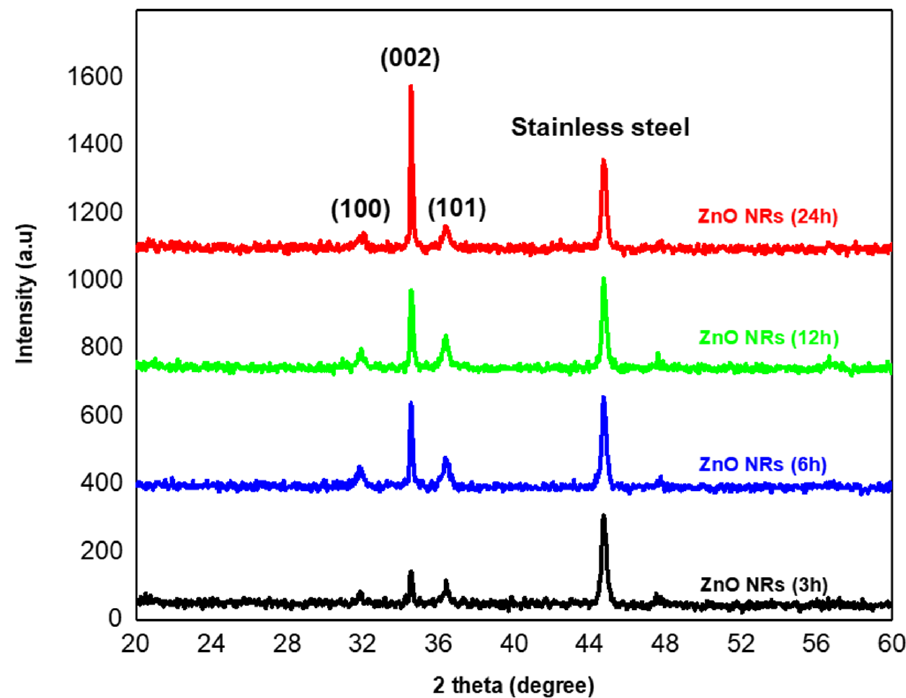
Figure 8. X-ray diffraction (XRD) patterns of the ZnO nanowire arrays grown for 3 h, 6 h, 12 h, and 24 h.